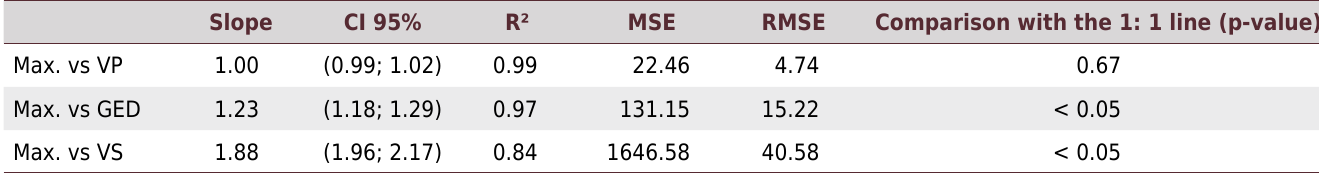
Table 2. Linear models adjusted for the maximum emission values (Max.) and the Vacuum by Manual Pump (VP), Vacuum by syringe (VS) and Gas Exchange by Displacement (GED) methods emissions; and associated statistical parameters Slope CI 95% R² MSE RMSE Comparison with the 1: 1 line (p-value) Max. vs